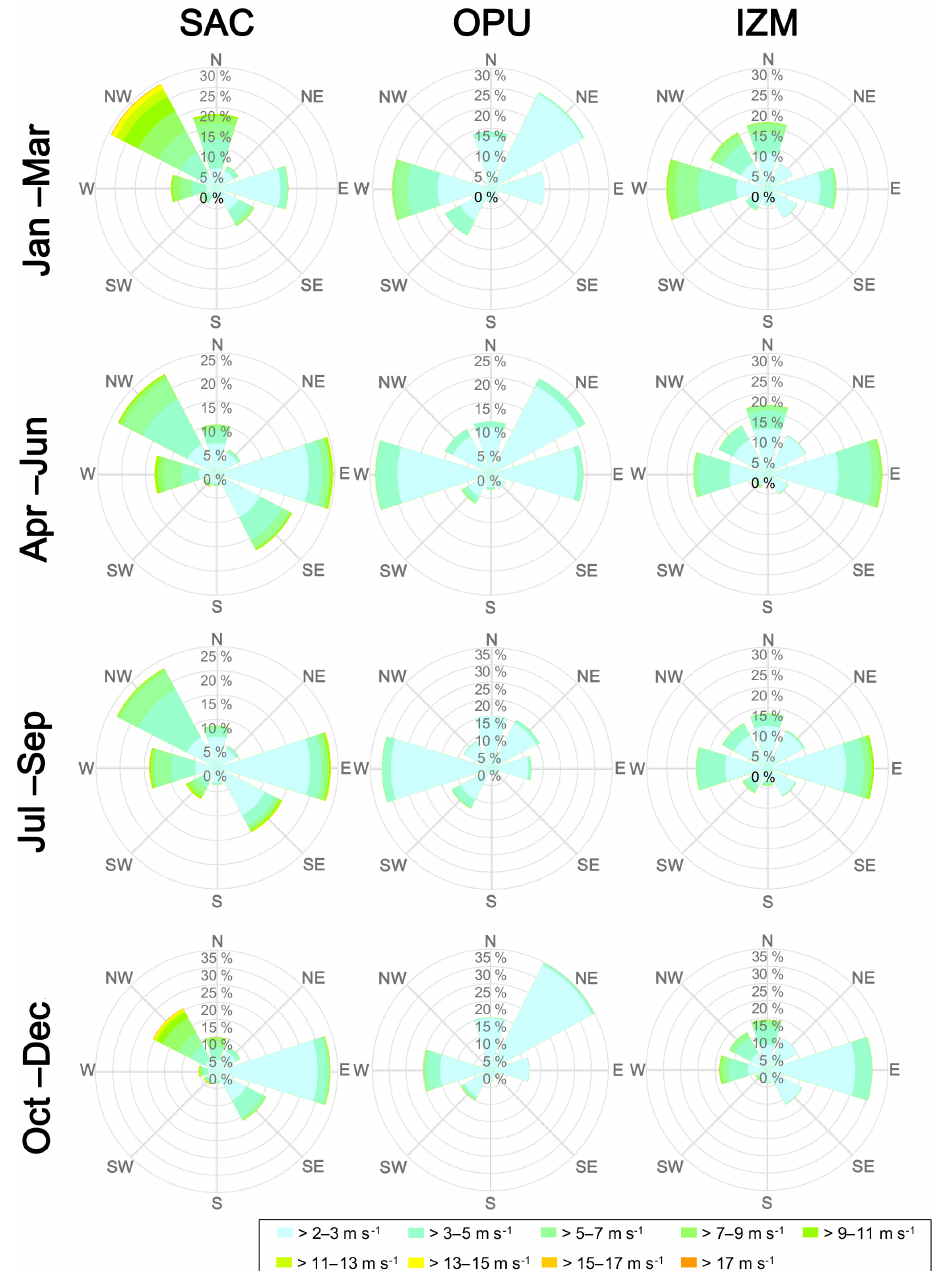
Figure A1. Relative wind frequency distributions at the three sites during the study period in 2015 for each season. Data are binned in 45 ◦